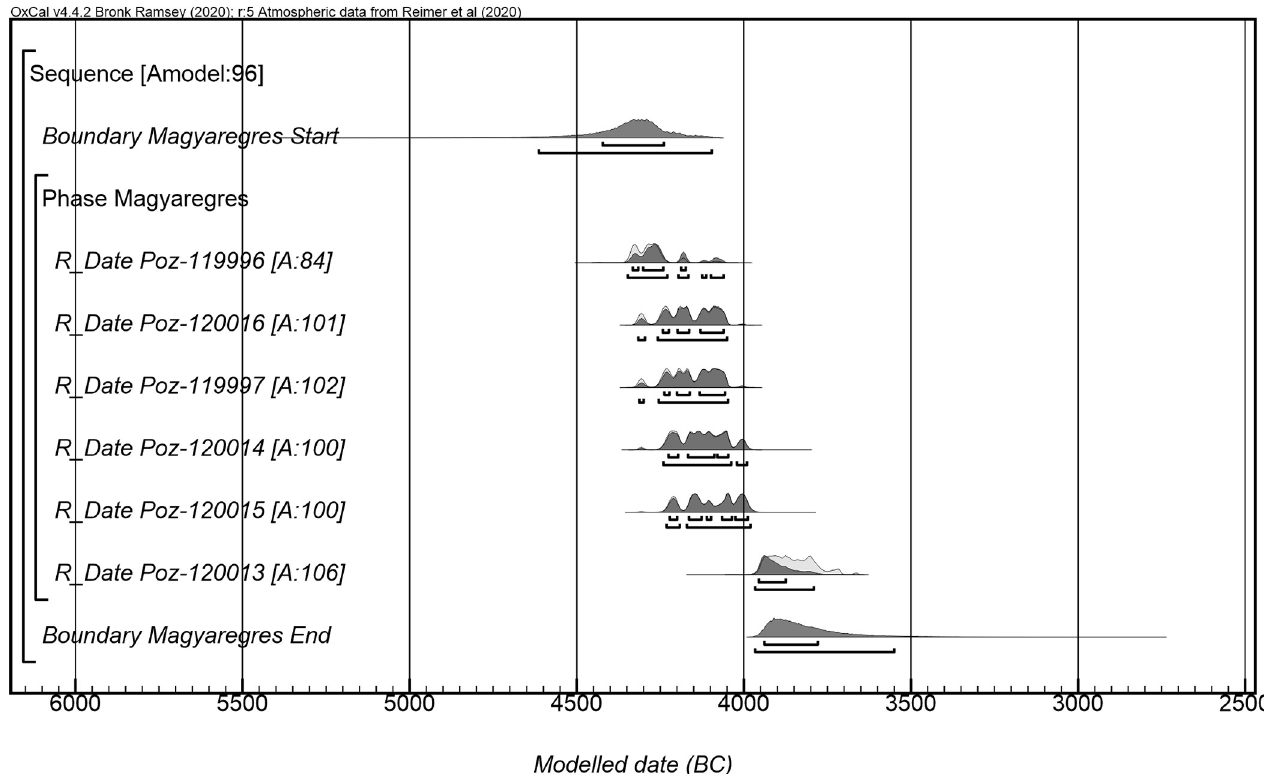
Fig 10. Probability distributions of radiocarbon dates from the Copper Age settlement of Magyaregres-Varga-Bonyi a´rokto´l keletre.